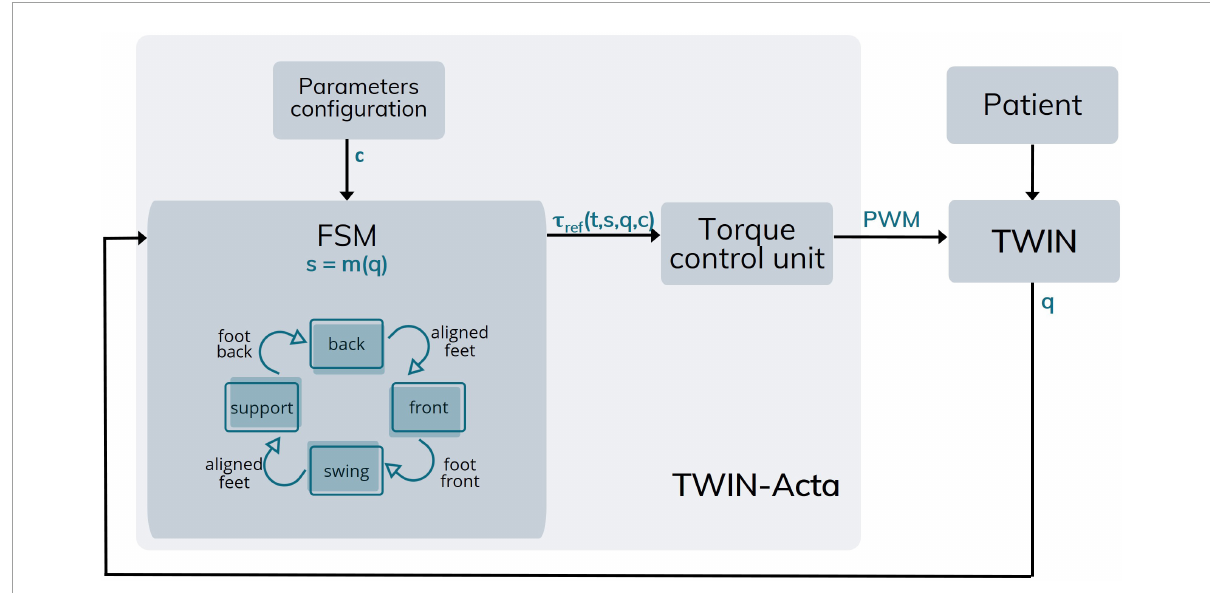
FIGURE5 Architecture of TWIN-Acta. Following parameters configuration (c), the FSM identifies the state of the TWIN exoskeleton [s = m(q)] in which the patient is (q). Specifically, the FSM recognizes the state of the plegic leg among the four possible–represented by the blue blocks, while the arrows represent state changes of the leg–and provides the reference torque which is a function of time, exoskeleton state, position, and configuration parameters [ τ ref (t,s,q,c)]. The torque control unit provides the assistance (torques) to be delivered to TWIN joints [brushless DC motors controlled via pulse width modulation